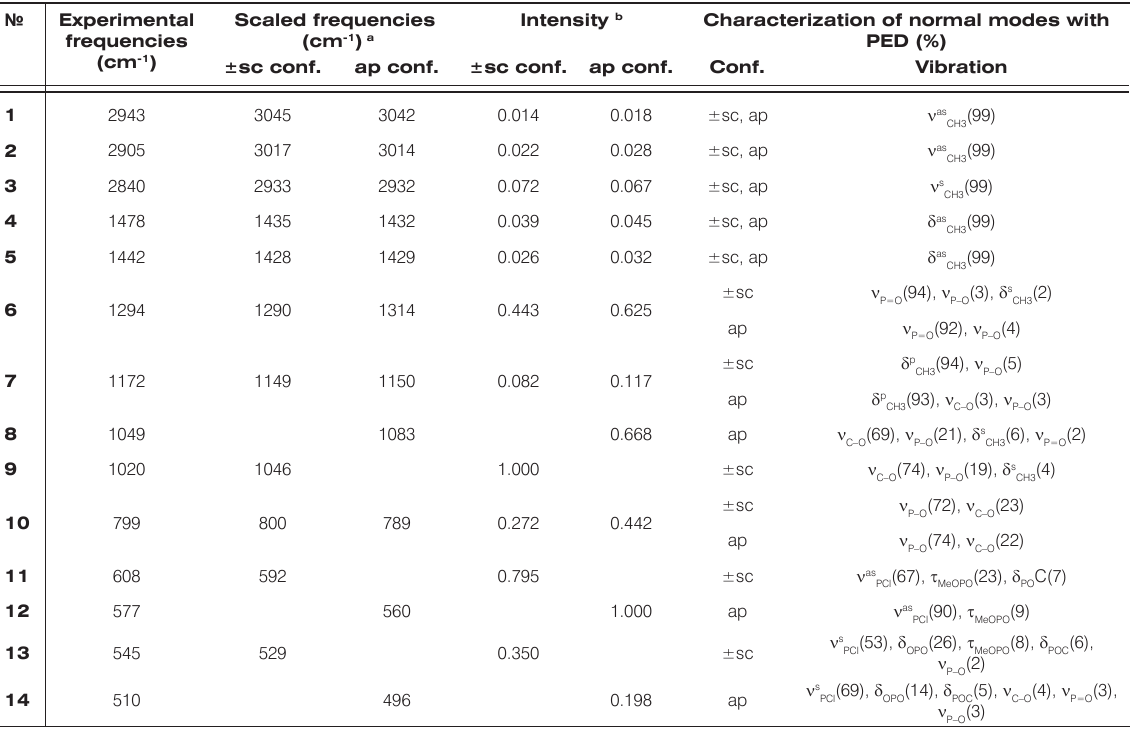
Table 2. Assignments of fundamental vibrations of methyl dichlorophoshate. № Experimental